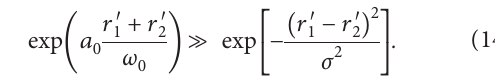
Figure 1: Influence of a 0 on PCAFABs’ evolution characteristics; other parameters are fixed as λ C n 2 � 10 − 13 m − 2/3 : (a) incident PCAFABs, a 0 � 0.01; (b) incident PCAFABs, a 0 � 0.1; (c) incident PCAFABs, a 0 � 0.5; (d) beam transverse acceleration parabolic trajectory for three a 0